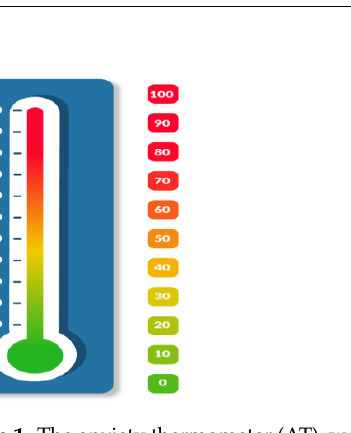
Figure 1. The anxiety thermometer (AT); we created this image following Mitchell’s et al. Indications [36].